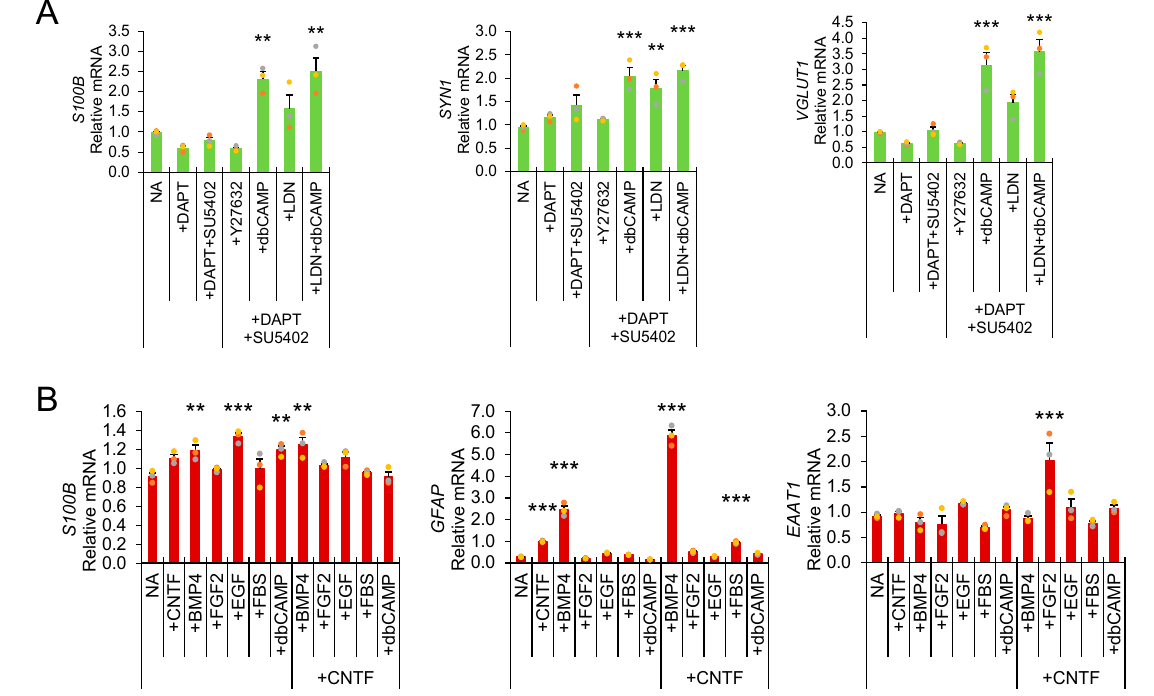
Figure 4. Example application of rapid direct lysis RT-qPCR assay for identification of neuronal and astrocyte differentiation factors. ( A ) Neuronal differentiations with combinations of Notch inhibitor DAPT, rock inhibitor Y27632, tyrosine kinase inhibitor SU5402, BMP4 inhibitor LDN-193189 (astroglial differentiation inhibitor), and cyclic AMP agonist db-cAMP. ( B ) Direct lysis RT-qPCR of astrocyte differentiation assays (one-way ANOVA with Holm–Sidak post hoc multiple comparisons test ** p < 0.01, *** p <